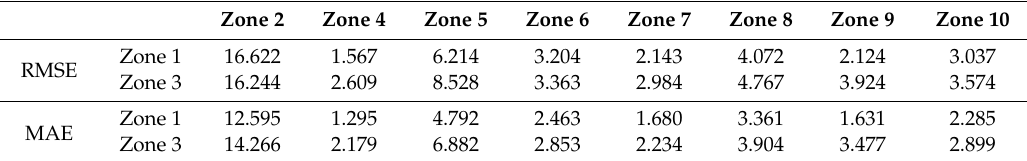
Table 16. Comparison of transfer results of di ff erent source